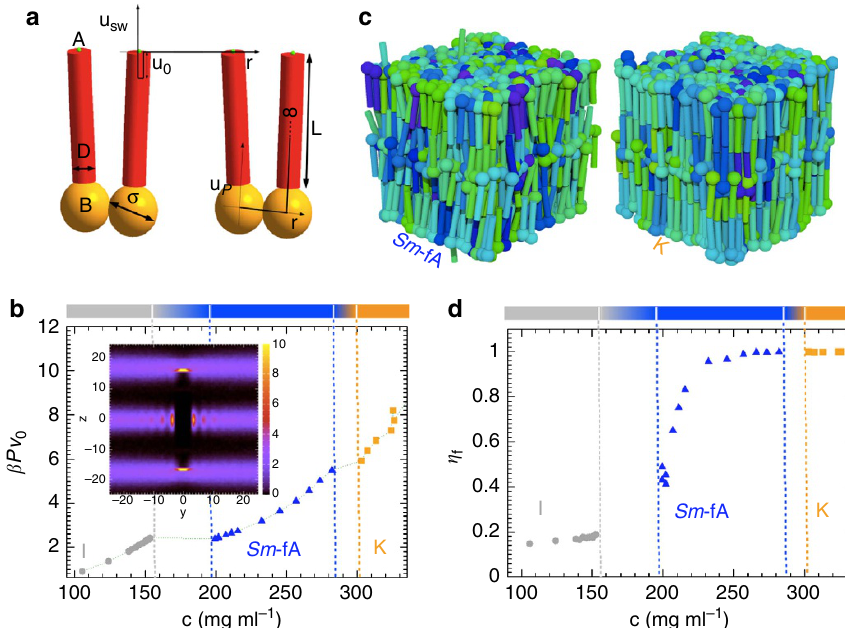
Figure 5 | Monte Carlo simulations. ( a ) The model for the G 20T -duplex molecule used in the simulations. The red parts are hard-core, stiff cylinders. The centres A of the small green spheres, which model the end-to-end attraction, interact via the square well potential u SW (shown on the top), while the centres B of the big orange sphere belonging to the same gapped duplex, which model the flexible spacer, interact via the potential u P (shown on the bottom-right). The diameter of the orange and green sphere indicate the interaction range and m 0 is the depth of the well of the square well potential m SW , that is, it is the binding energy. ( b ) Equation-of-state for the G 20T -duplex obtained from simulations. Inset: plot of g (0, y , z ), which corresponds to correlations parallel to the nematic director ( z -axis), for the Sm -fA state point corresponding to b Pv 0 ¼ 4.1. ( c ) Snapshots of selected phases. Cylinders belonging to the same molecule have the same colour to evidence the overwhelming number of duplexes in folded configurations. Left: the Sm-fA phase for b Pv 0 ¼ 4.1. Right: the crystal K-phase for b Pv 0 ¼ 6.4. ( d ) Fraction of folded G-duplex Z f as a function of